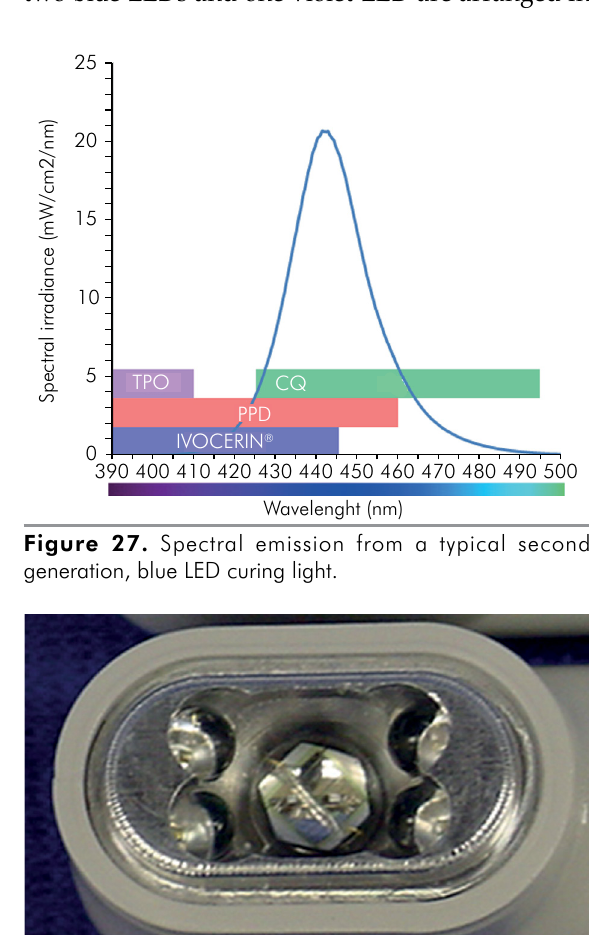
77 Braz. Oral Res.